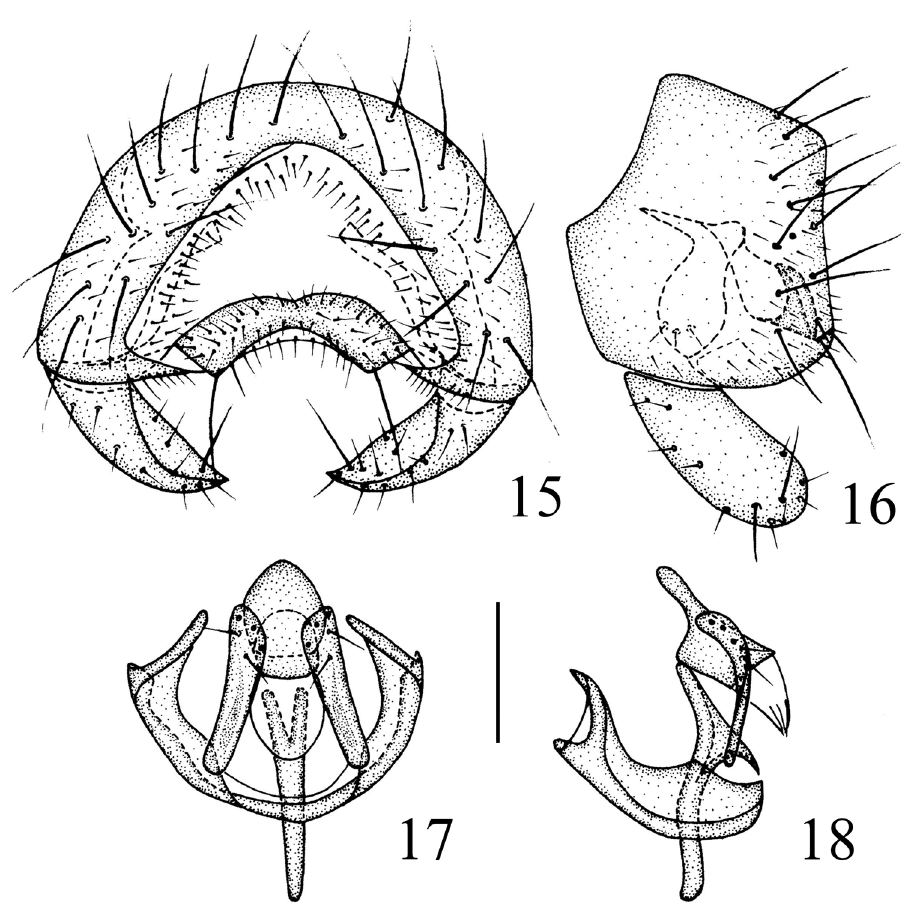
Figures 15–18. Siphunculina shangyongensis sp. n., holotype. 15 epandrium, posterior view 16 epan- drium, lateral view 17 hypandrium and phallic complex, ventral view 18 hypandrium and phallic complex, lateral view. Scale bar: 0.1